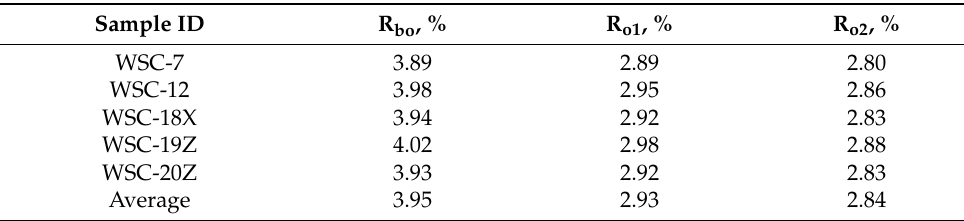
Table 2. Conversion results of vitrinite reflectance and bitumen reflectance of lower Cambrian black shale in Wenshuicun, Guizhou.